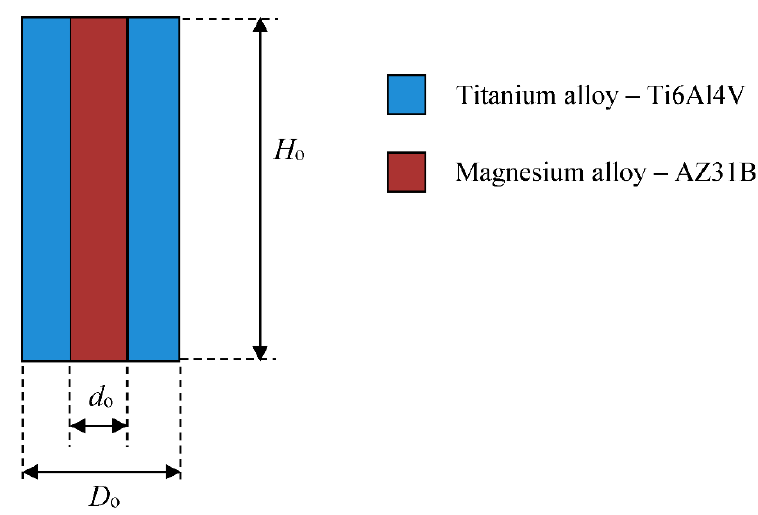
Figure 1. Bimetallic cylinder sketch and initial geometrical dimensions.